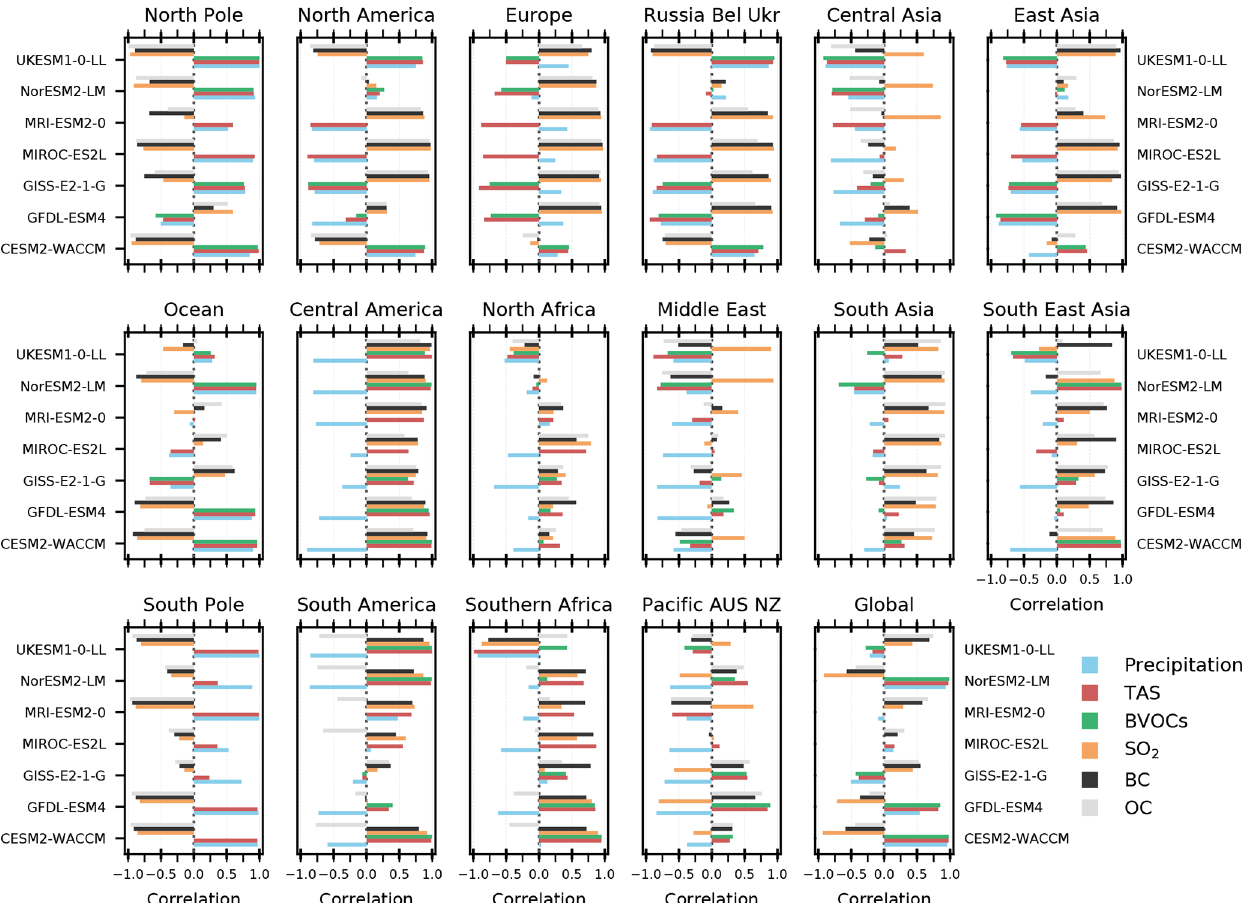
Figure 16. Correlation coefficients calculated when comparing future annual mean surface PM 2 . 5 concentrations against individual variables from individual CMIP6 models (that had data out to 2100) over the period 2015 to 2100 in the ssp370 scenario: precipitation; surface air temperature (TAS); emissions of biogenic volatile organic compounds (BVOCs); and emissions of SO 2 , black carbon (BC) and organic carbon